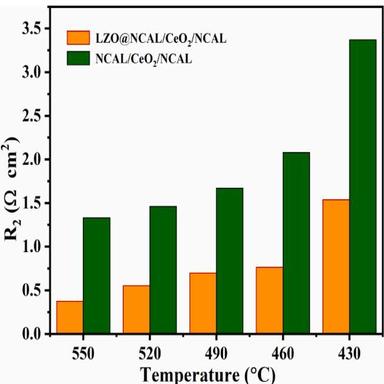
Polarization resistance of NCAL with and without LZO coating tested at various temperatures in fuel cell condition.